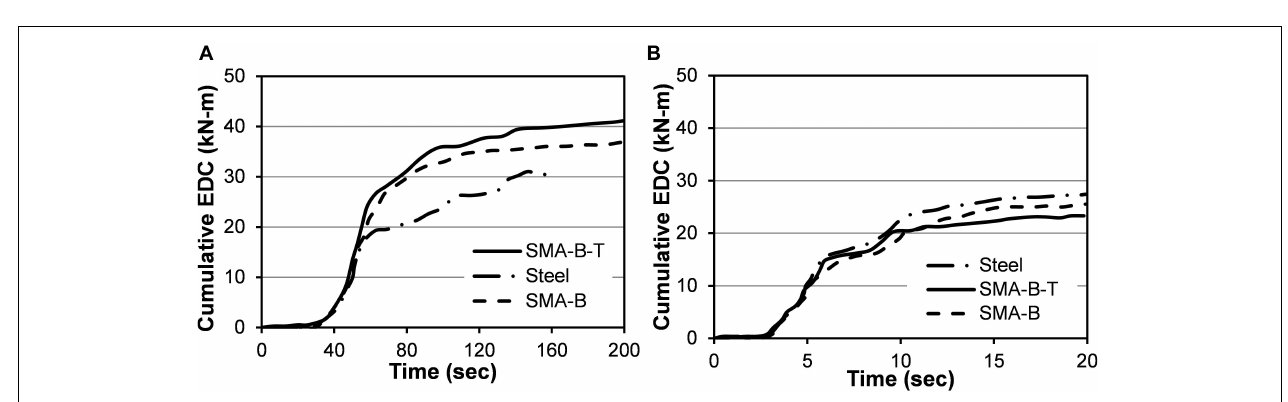
FIGURE 14 | IDA curves for residual drift for (A) SMA-B, (B) SMA-B-T, and (C) Steel-RC bent under short duration motion.